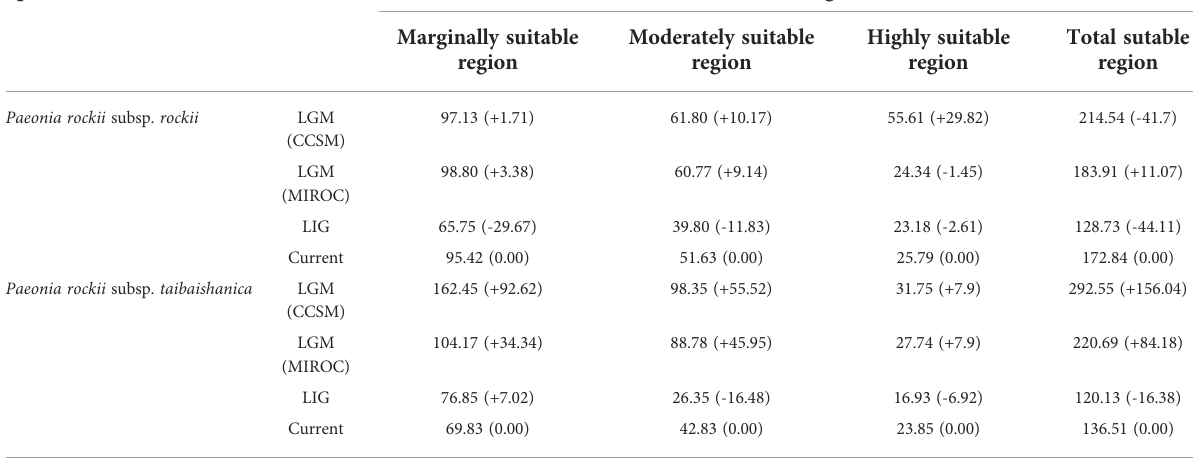
TABLE 3 The potential distribution area of the two Paeonia species in different periods. Species